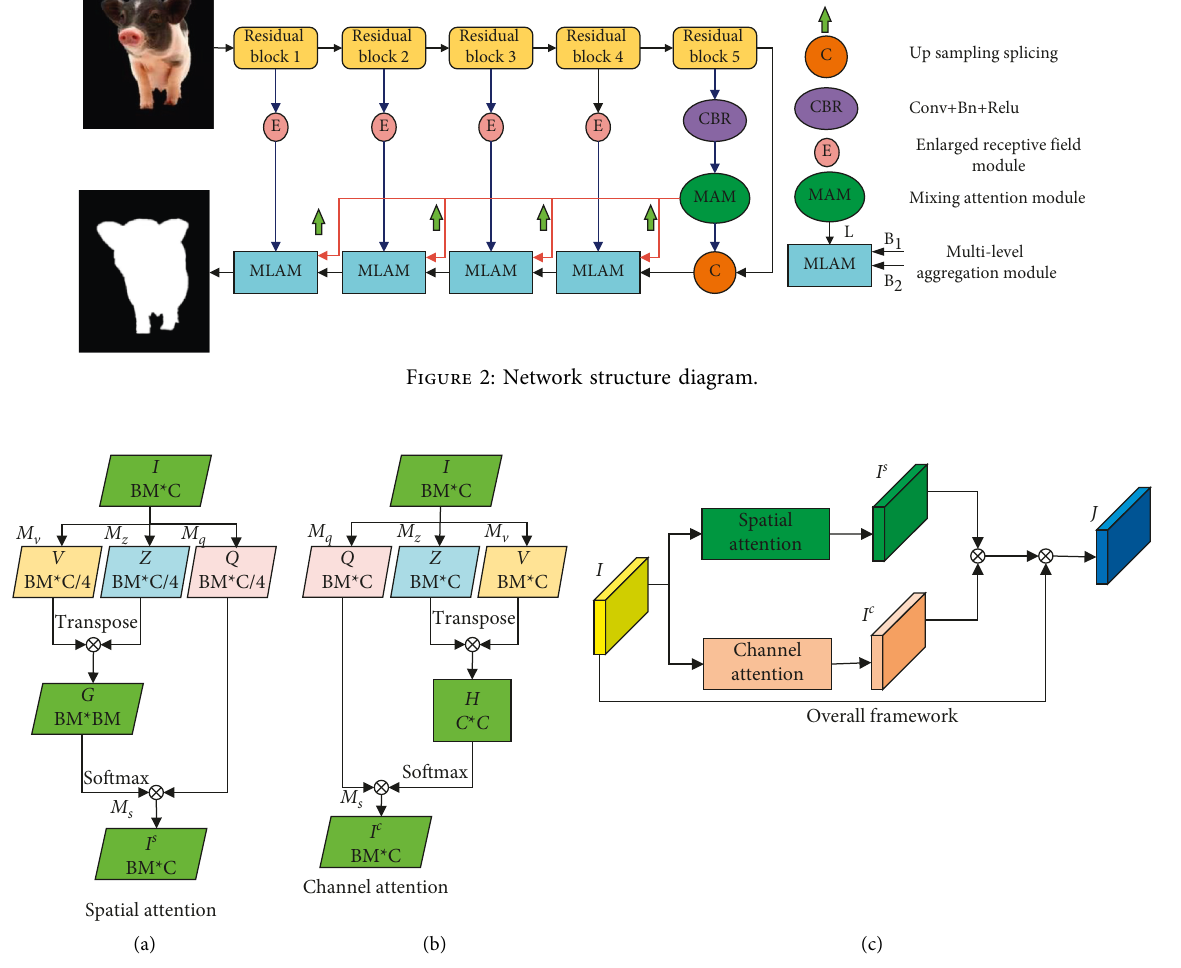
Figure 3: Mixing attention module. (a) Spatial attention, (b) channel attention, and (c) overall